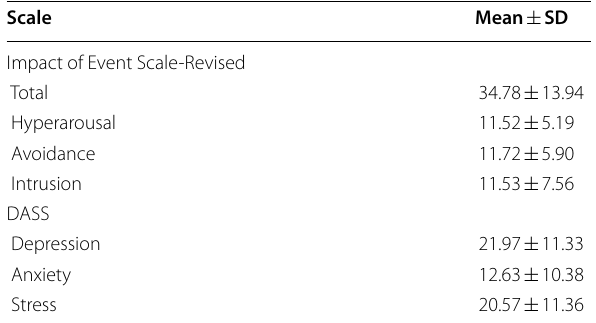
Table 3 Prevalence of IES, depression, anxiety and stress symptoms among the studied